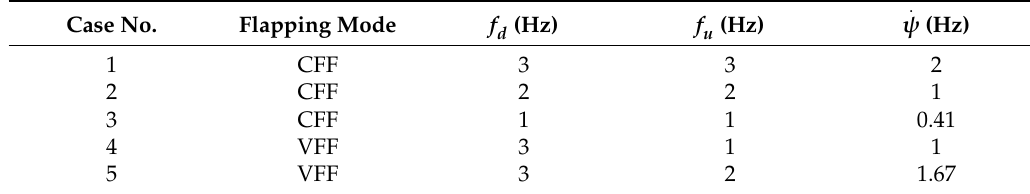
Table 2. Flapping frequency and corresponding rotational angular